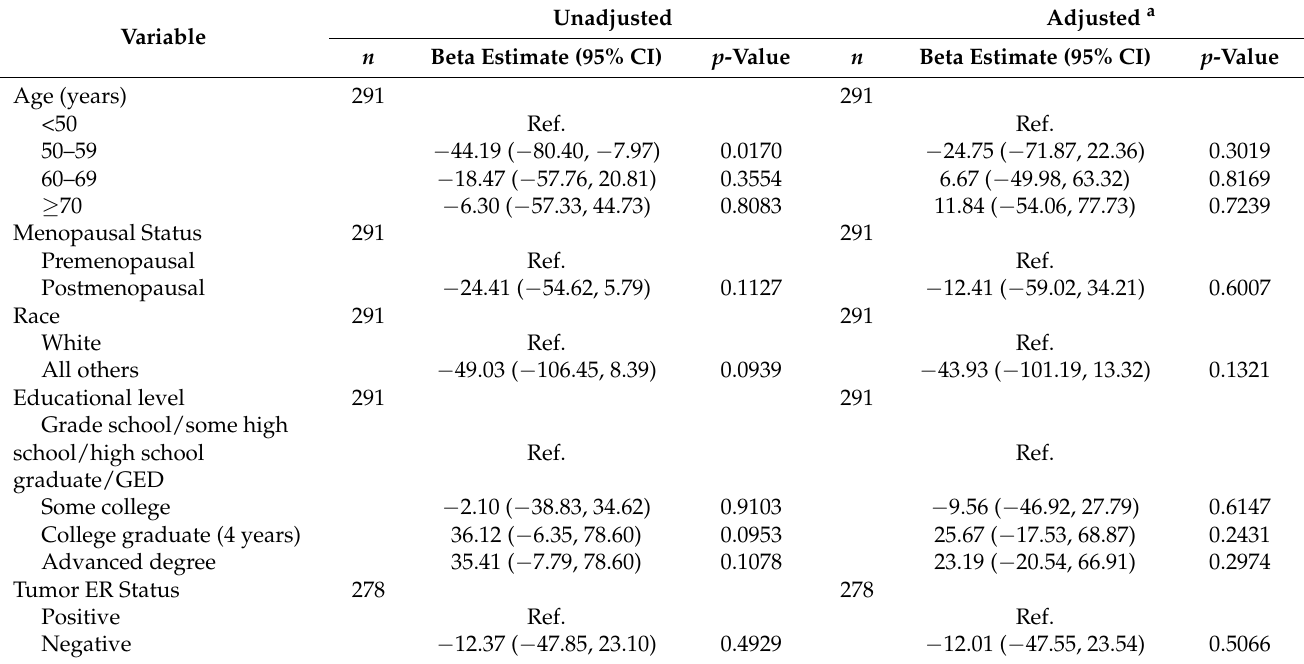
Table 3. Associations of demographic variables with urinary creatinine-corrected triclosan concentration.